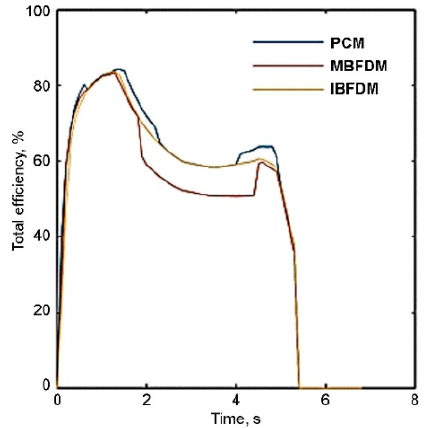
Figure 7. Change in overall efficiency.